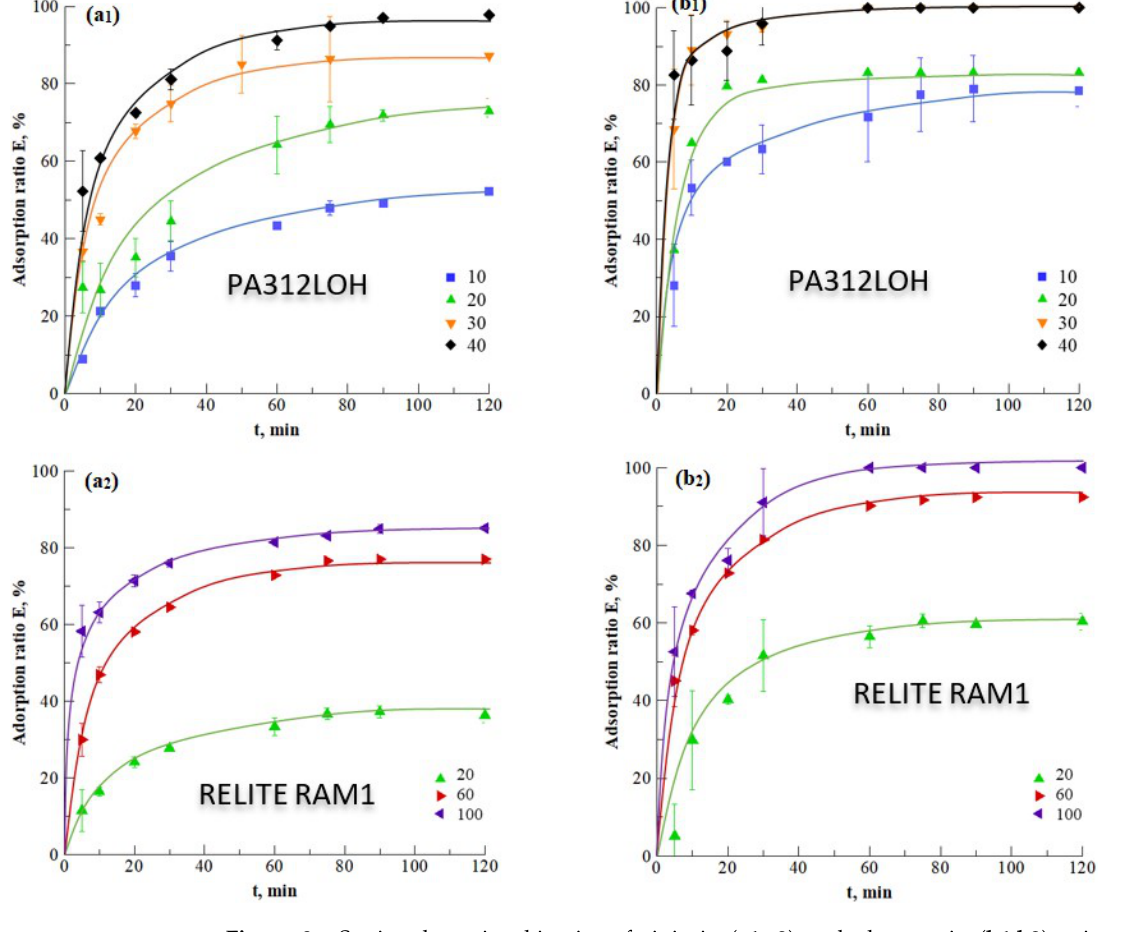
Figure 3. Static adsorption kinetics of sinigrin ( a1 , a2 ) and gluconapin ( b1 , b2 ) using strongly (PA312LOH) and weakly basic resin (RELITE RAM1) with various solid-liquid ratio (g resin /L juice ) at 30 °C and 300 rpm.